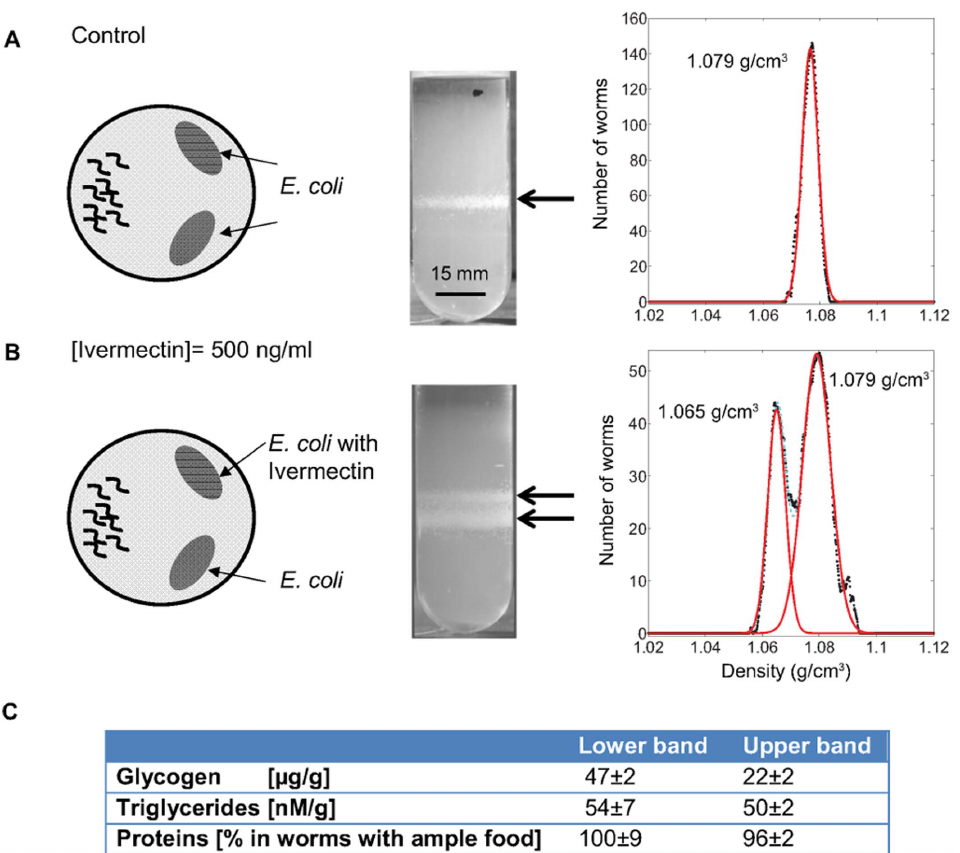
Figure 5. Demonstration of a density-based assay. (A) Worms grown on agar plates without drugs (control). The distribution of densities was unimodal. (B) Worms grown on agar plates with one lawn of bacteria containing Ivermectin. The distribution of densities after six hours was bimodal. Red lines are Gaussian fits to the data. (C) Composition of the worms extracted from the lower band (not exposed to drug) and upper band (exposed to drug). Worms in the lower band had approximately half the glycogen content of worms in the upper band, consistent with a starvation-like response.